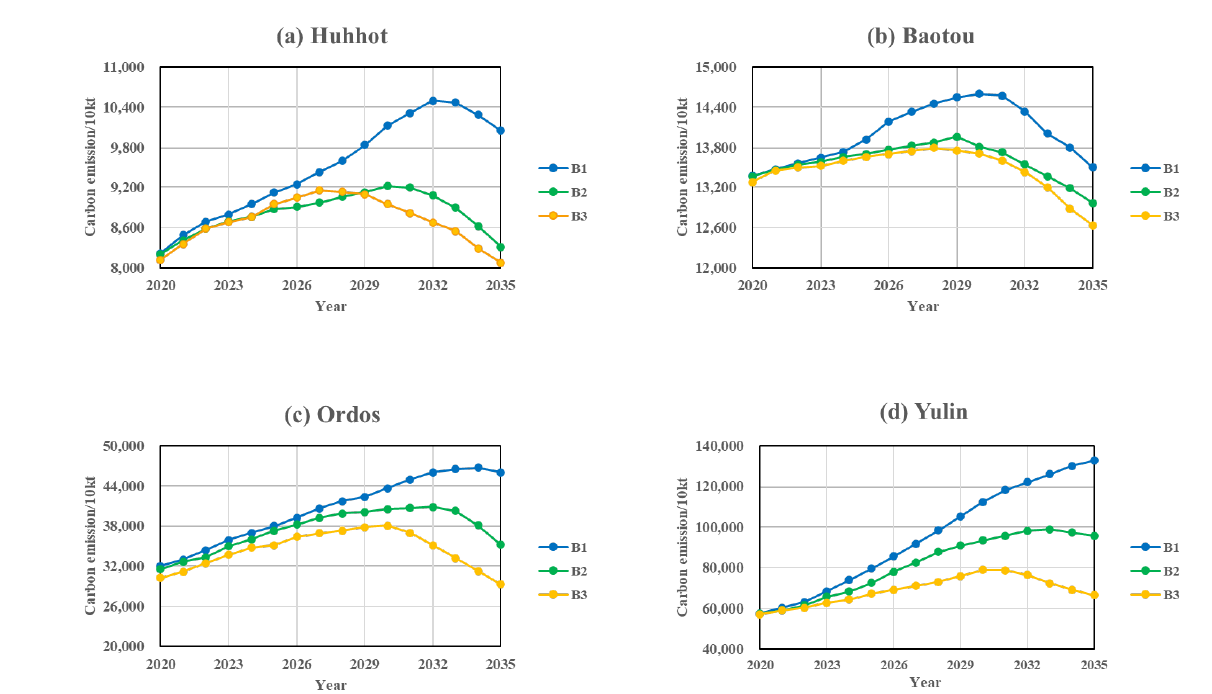
Figure 7. Projections of urban carbon emissions under the comprehensive regulation scenario. Table 10. Reduction rate of average cumulative carbon emissions over the projection period compared to the baseline scenario under different comprehensive scenarios (%).